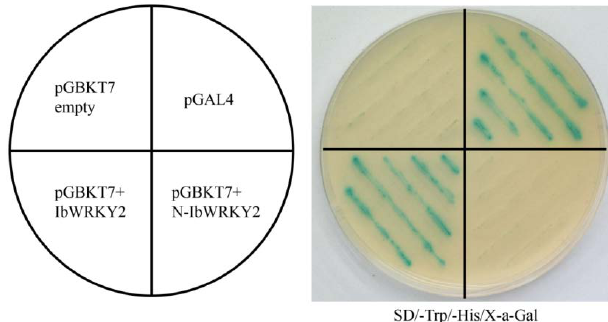
Figure 5. Transactivation activity assay of full-length and truncated IbWRKY2 in yeast. pGBK7+IbWRKY2, representing the full-length IbWRKY2, and pGBK7+N-IbWRKY2, representing IbWRKY2 with 246 aa removed from the N-terminal region, were transformed into the yeast strain AH109 and examined on SD/ − Trp/ − His selection medium with X- α -Gal. The pGBKT7 empty vector and pGAL4 were used as negative and positive controls, respectively.